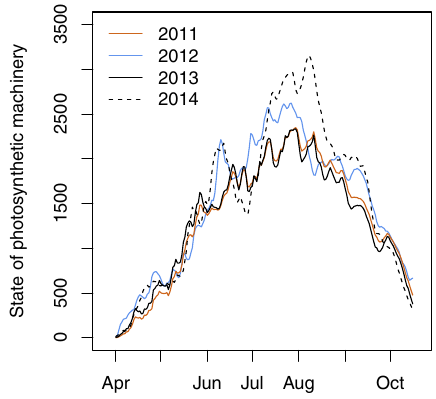
Figure 1. The annual pattern of the state of the photosynthetic ma- chinery ( S , arbitrary units) during the years 2011–2014 in Finnish Lapland, 68 ◦ N.